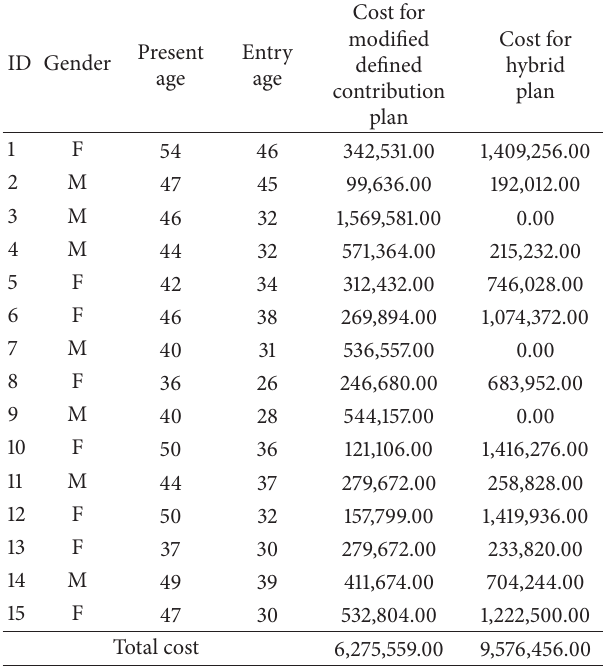
Table 8: Present value of compensation